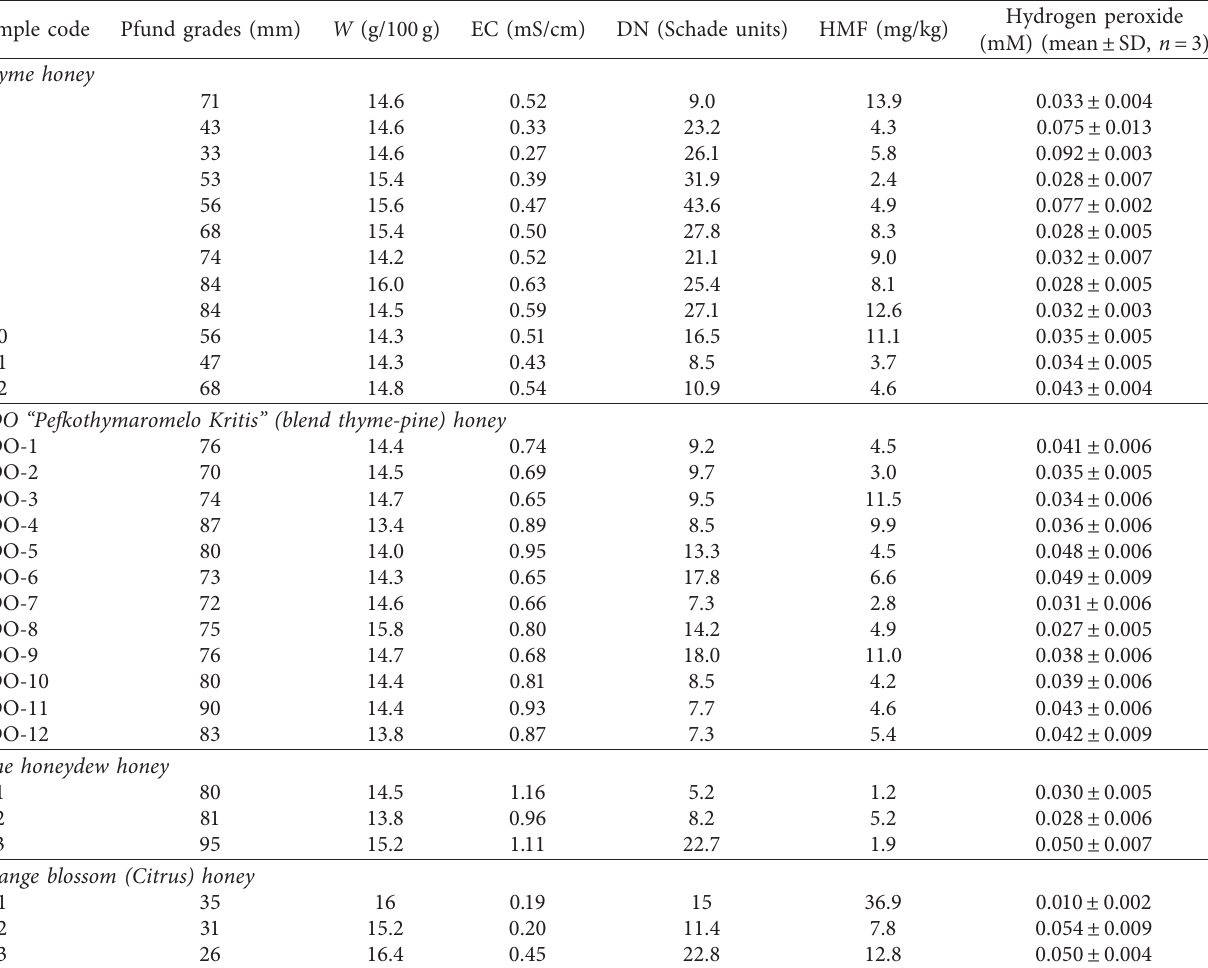
Table 1: Results for color (Pfund grades), moisture content ( W ), electrical conductivity (EC), diastase activity (DN), hydroxymethylfurfural (HMF), and hydrogen peroxide (mM in 30% v/v aqueous honey solution) from honeys of different botanical origins. Sample